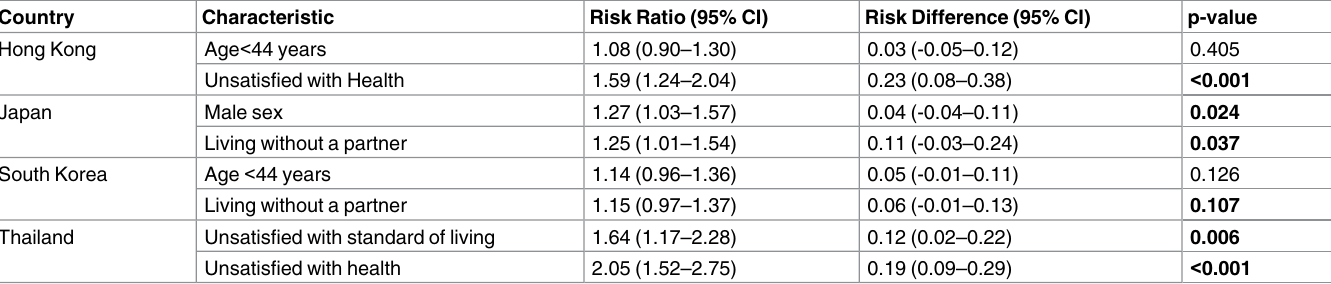
Table 5. Multivariate regression models for lower trust (trust ‘not at all’ or ‘not much’) in TV/Media in each country.